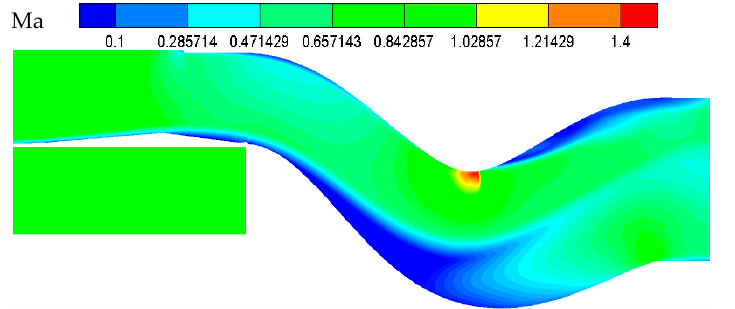
Figure 6. Mach number distribution of the symmetrical section.